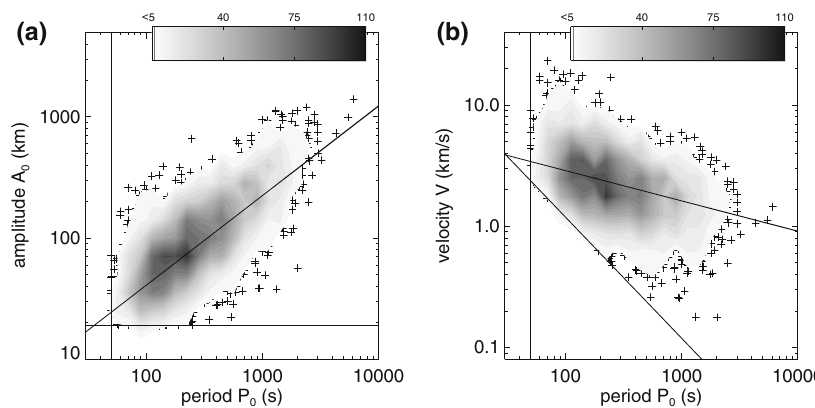
Fig. 10 Hinode/SOT H α observation of transverse thread oscillations in a quiescent prominence. Correla- tions between a the displacement amplitude and initial period and b velocity amplitude and initial period. The density of points is displayed as a contour plot, with plus signs showing the positions of individual points in low density regions. Solid lines through the middle of the contour plots represent the power-laws . 74 ± 0 . 04 b V = 10 0 . 96 ± 0 . 02 P − 0 . 25 ± 0 . 04 fitted to the data: a A 0 = 10 0 . 13 ± 0 . 02 P 0 0 and 0 . The other two lines show the observational limits of detection. Image reproduced with permission from Hillier et al.